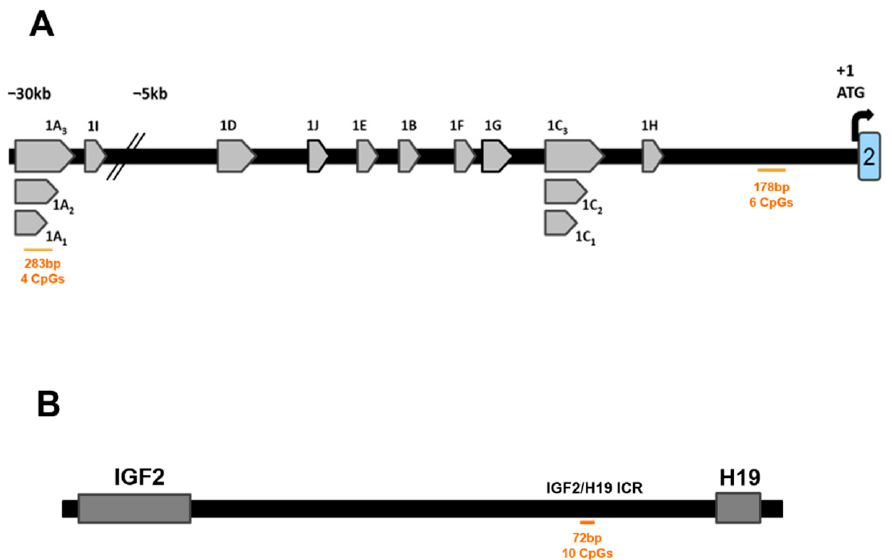
Figure 1. Structure of the human NR3C1 and IGF2/H19 ICR . ( A ) Structure of the distal and proximal promoters of the human NR3C1 . Numbers (in orange) represent the sequence fragments that were amplified in this study. ( B ) Structure of the IGF2/H19 ICR . Numbers (in orange) represent the sequence fragments that were amplified in this study.